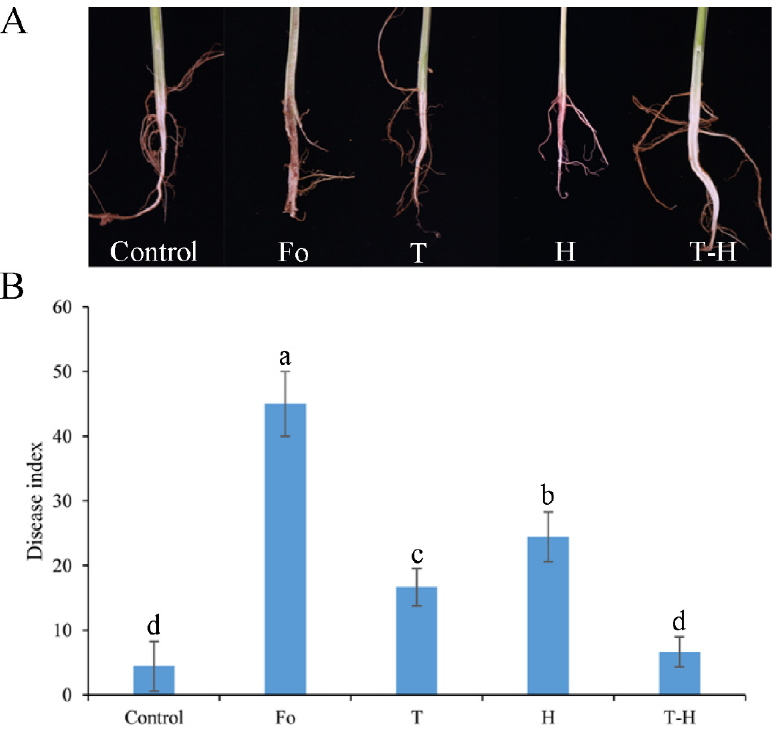
Figure 6. The effect of the combination of T. asperellum SC012 and hymexazol to control cowpea Fusarium wilt in greenhouse. ( A ) The symptoms of cowpea root; ( B ) the disease index of cowpea Fusarium wilt. “Control”, “Fo”, “T”, “H” and “T-H” stand for “blank control”, “negative control”, “ Trichoderma treatment”, “hymexazol treatment” and “combination treatment”, respectively. Data presented are the means ± SE. Different letters indicate significant difference ( p < 0.05) among the treatments.